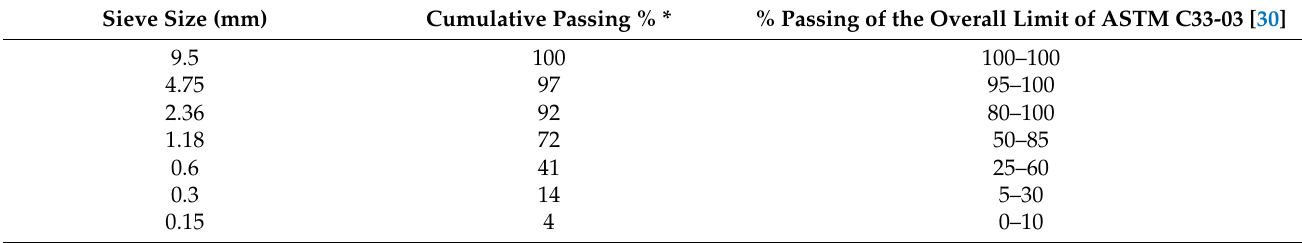
Table 3. Sieve analysis of the fine